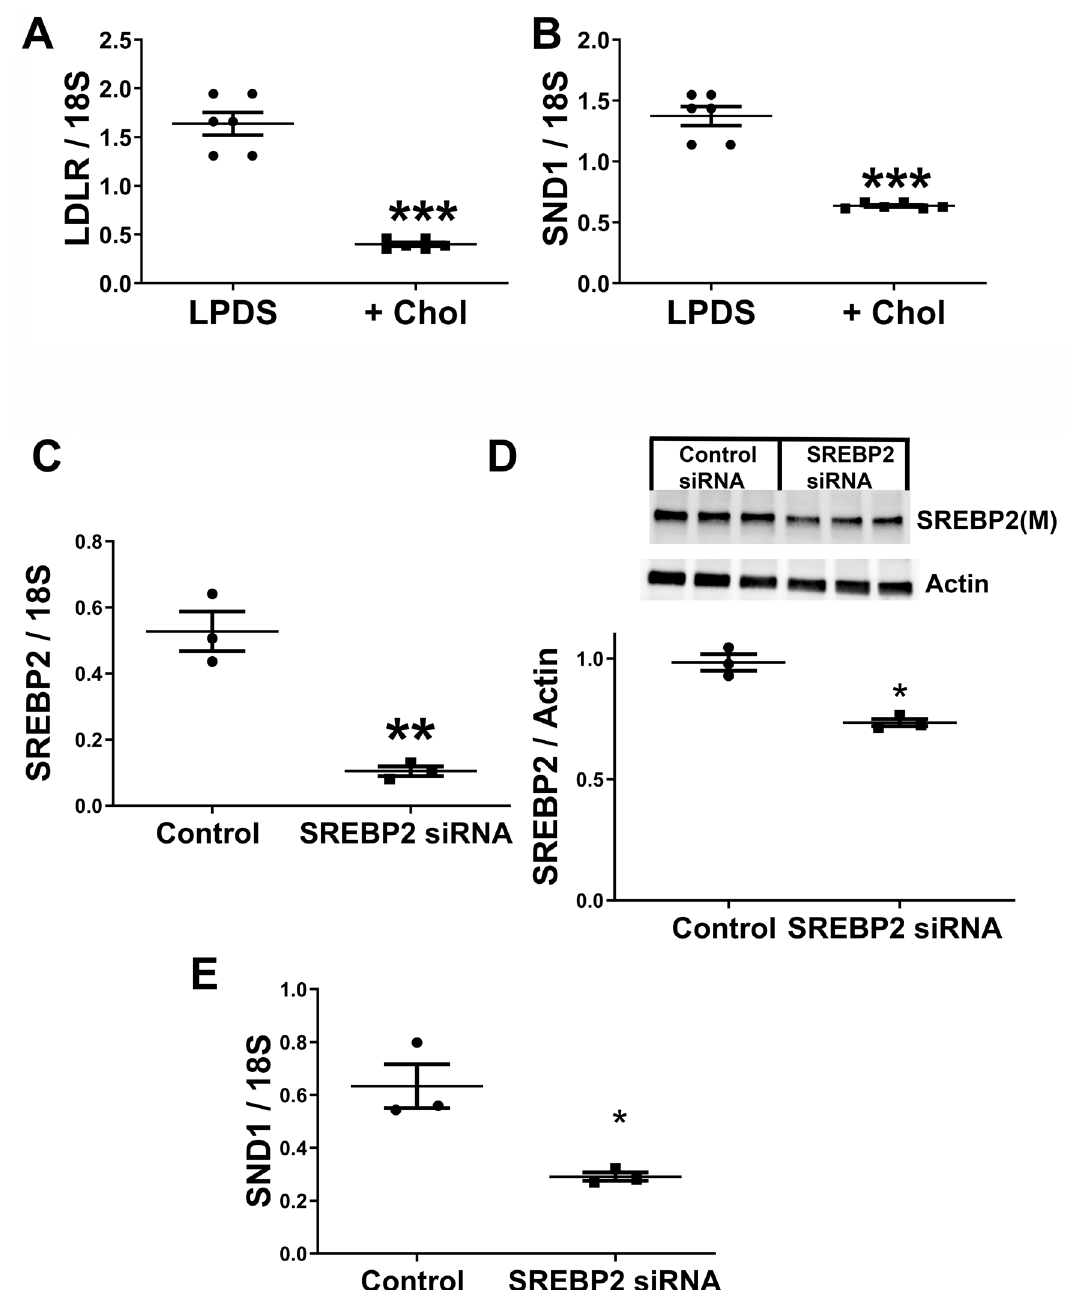
Figure 5. SREBP2 regulates Snd1 mRNA expression. ( A , B ) Differentiated 3T3-L1 adipocytes were treated with lipoprotein deficient serum containing media (LPDS) for 24-h. The cells were then incubated in LPDS or LPDS with cholesterol (Chol) as indicated. Real-time RT-PCR was used to measure the gene expression of Ldlr and Snd1 . Next, differentiated 3T3-L1 adipocytes were treated with control (scrambled) or SREBP2 siRNA. ( C ) SREBP2 mRNA expression was measured. (D ) SREBP2 (M:mature form) and actin were immunoblotted and quantified. ( E ) SND1 mRNA expression was determined. The data are represented as the mean ± SEM (n = 6 (A and B) or n = 3 ( C – E ); *P < 0.05; **P < 0.01; ***P < 0.001 two-tailed unpaired Student’s